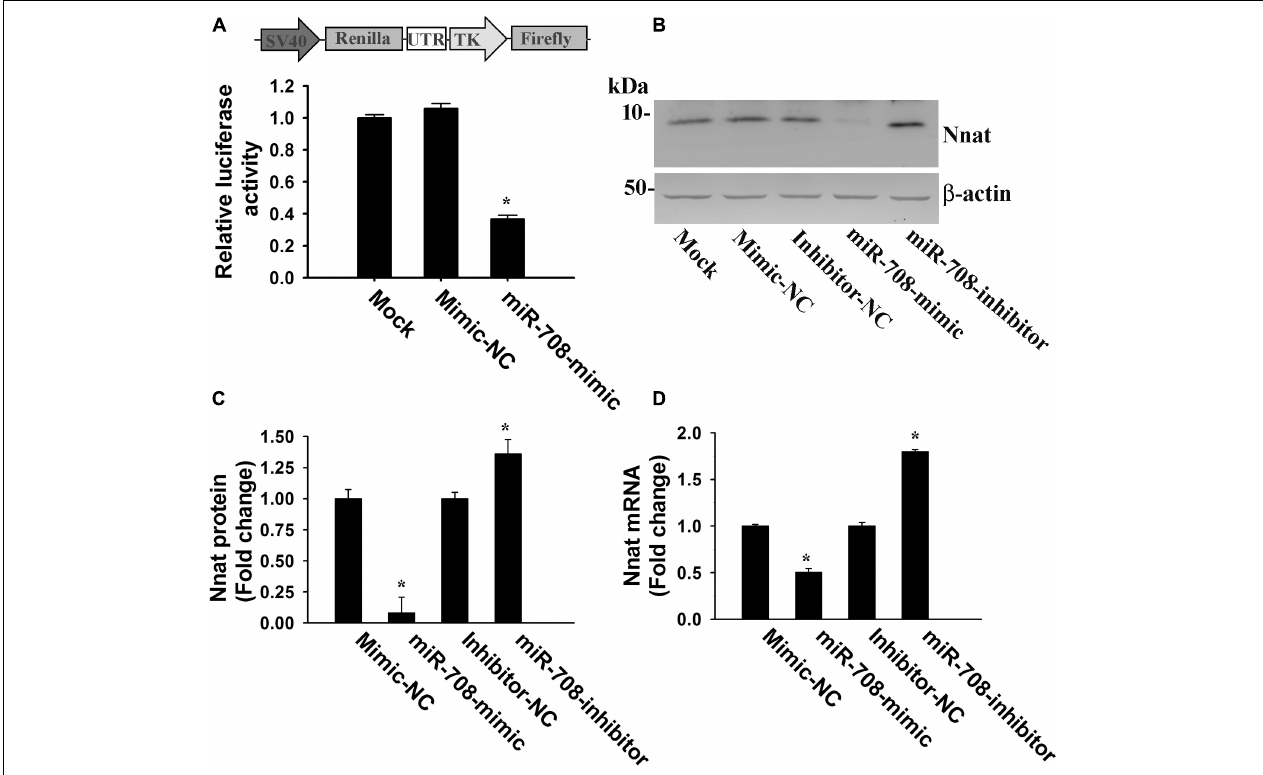
FIGURE 2 | Regulation of Nnat expression by miR-708. (A) The 3 (cid:48) -UTR of Nnat was cloned into a dual luciferase reporter vector and then transfected into neuro 2a cells in the presence of miR-708 mimic or mimic negative control (NC). Twenty four hours after transfection, cells were processed for dual-luciferase assay. (B–D) Neuro 2a cells were transiently transfected with miR-708 mimic, inhibitor and their negative controls separately and 24 h later cells were collected and subjected to either immunoblot or quantitative PCR analysis of Nnat. (B) Representative immunoblot of Nnat along with β -actin. (C) Quantitative analysis of band intensity of Nnat shown in B using NIH Image analysis software. (D) Quantitative RT-PCR analysis of Nnat mRNA levels. Values are mean ± SD of three independent experiments. ∗ P < 0.001 compared to respective control group.